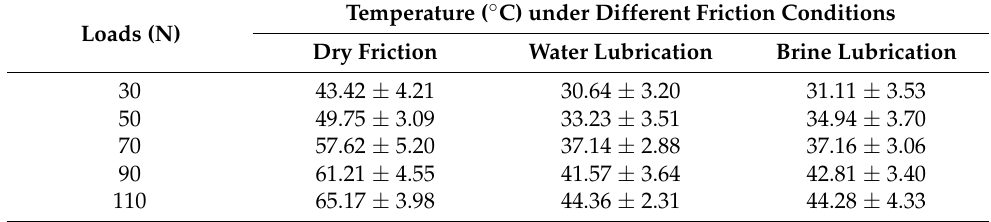
Table 3. Temperatures of UHMWPE surface at 500 r/min speed under different friction conditions. Loads